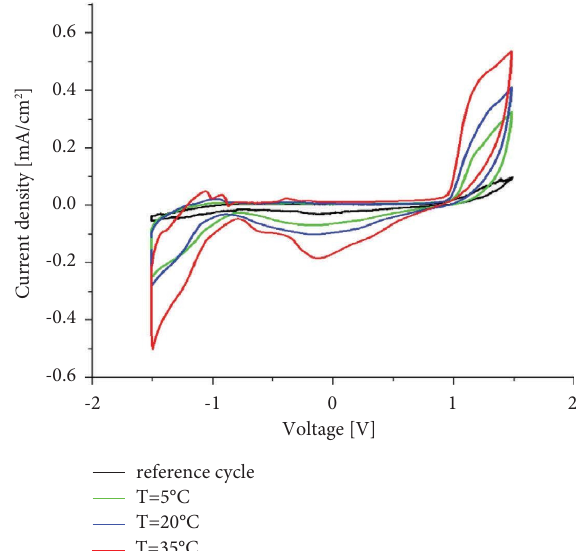
Figure 2: Typical cyclic voltammograms measured for the FTO electrodes over the same voltage range and diferent temperatures in pure distilled water, and the curves are obtained from an aqueous solution of 0.1M Pb(NO 3 ) 2 in 0.4M NaNO 3 .